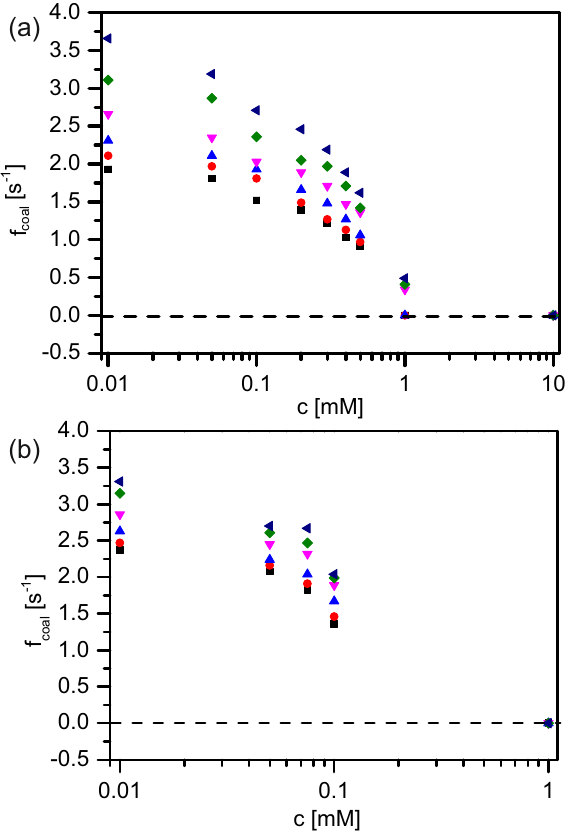
Figure 3. Coalescence trends in hexadecane-in-water with varying concentration of emulsifiers ( a ) SDS, ( b ) Tween 20. Different symbols denote the various temperatures at which the coalescence was measured: 20 ◦ ◦ (black squares), 30 C (red circles), 40 C (blue upward triangles), 50 ◦ (green diamonds) and 70 C (dark blue leftward triangles). The entire dataset along with the error bars are presented in the supplementary